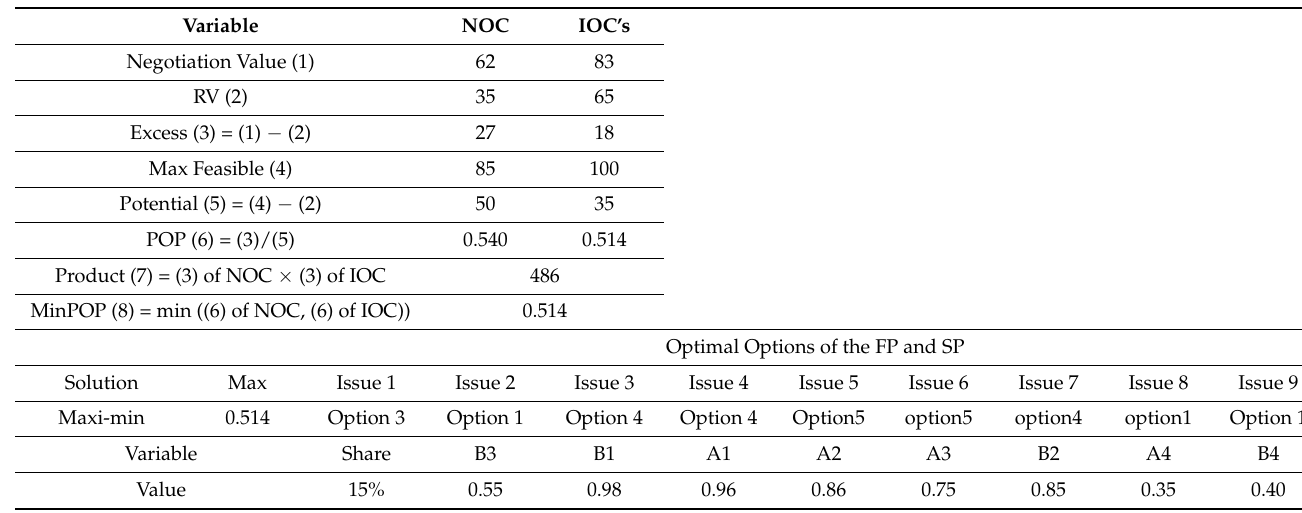
Table 10. Solver output of Maxi-min solution of the FP and SP.